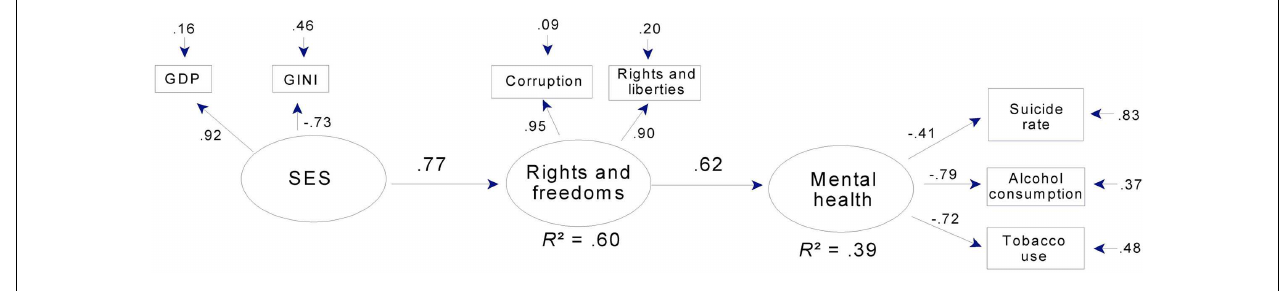
ratings for political rights and civil liberties (see text). Gini: high scores = economic inequality. GDP = Gross domestic product per capita.